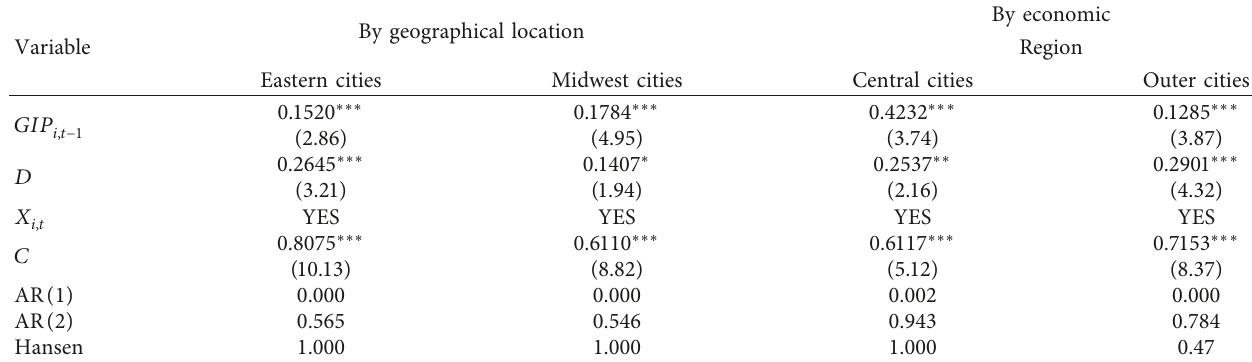
Table 4: The heterogeneity test